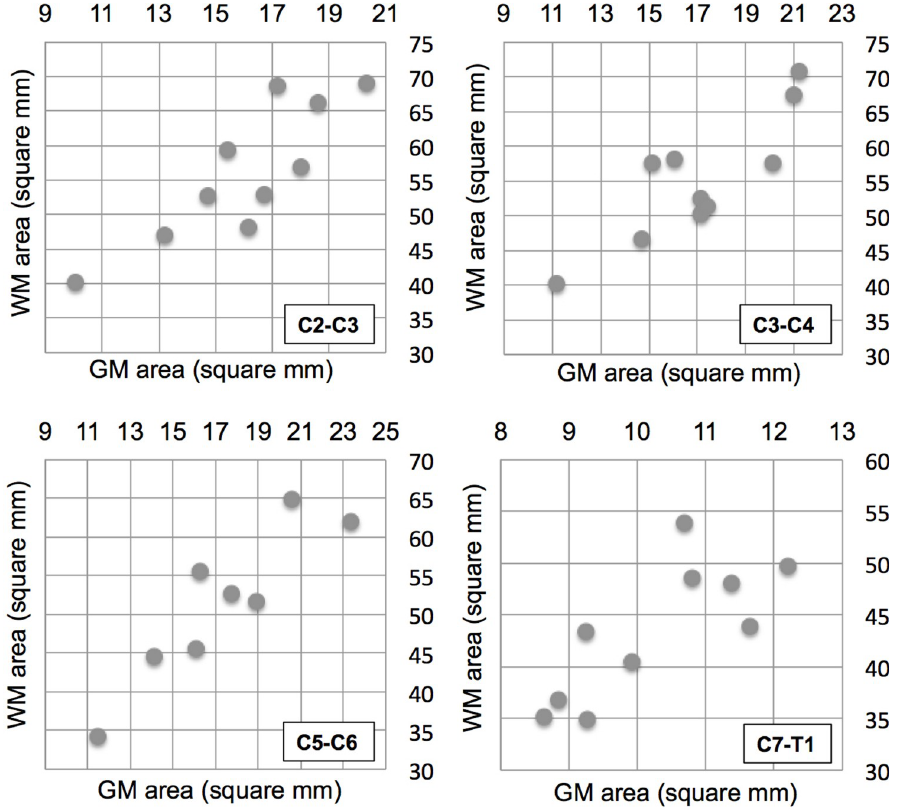
Fig 4. Association of gray and white matter spinal cord atrophy. Gray matter area (x-axis) and white matter area (y- axis) for the 10 MND patients at the four cervical levels (indicated at the bottom right of each